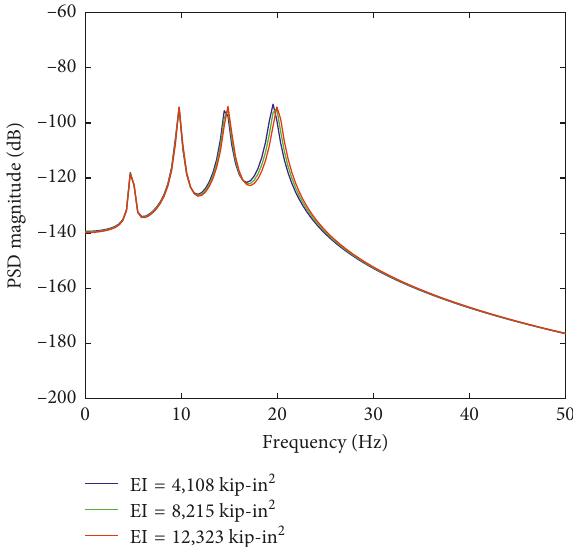
Figure 5: Analytic PSD function cable stiffness